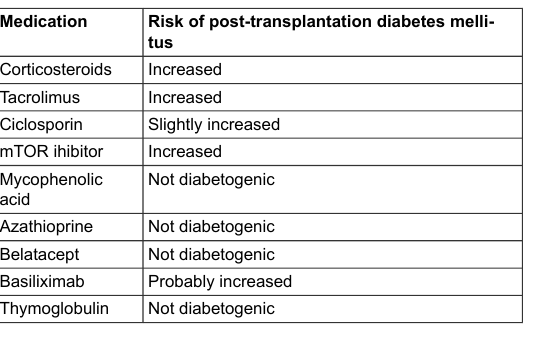
Table 8: Risk of post-transplantation diabetes mellitus with different medica-